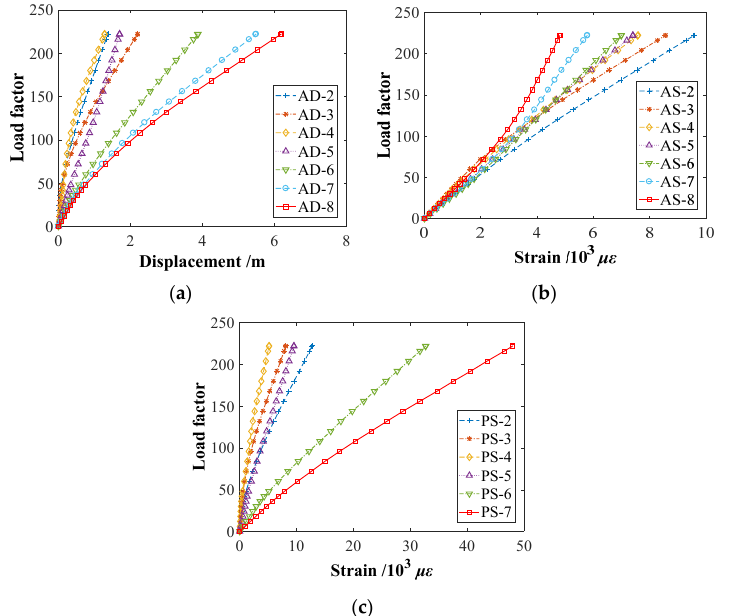
Figure 8. Numerical analysis of the load-carrying capacity. ( a ) Displacements of the upper arch ribs; ( b ) Strains of arch ribs. ( c ) Strains of pier columns.